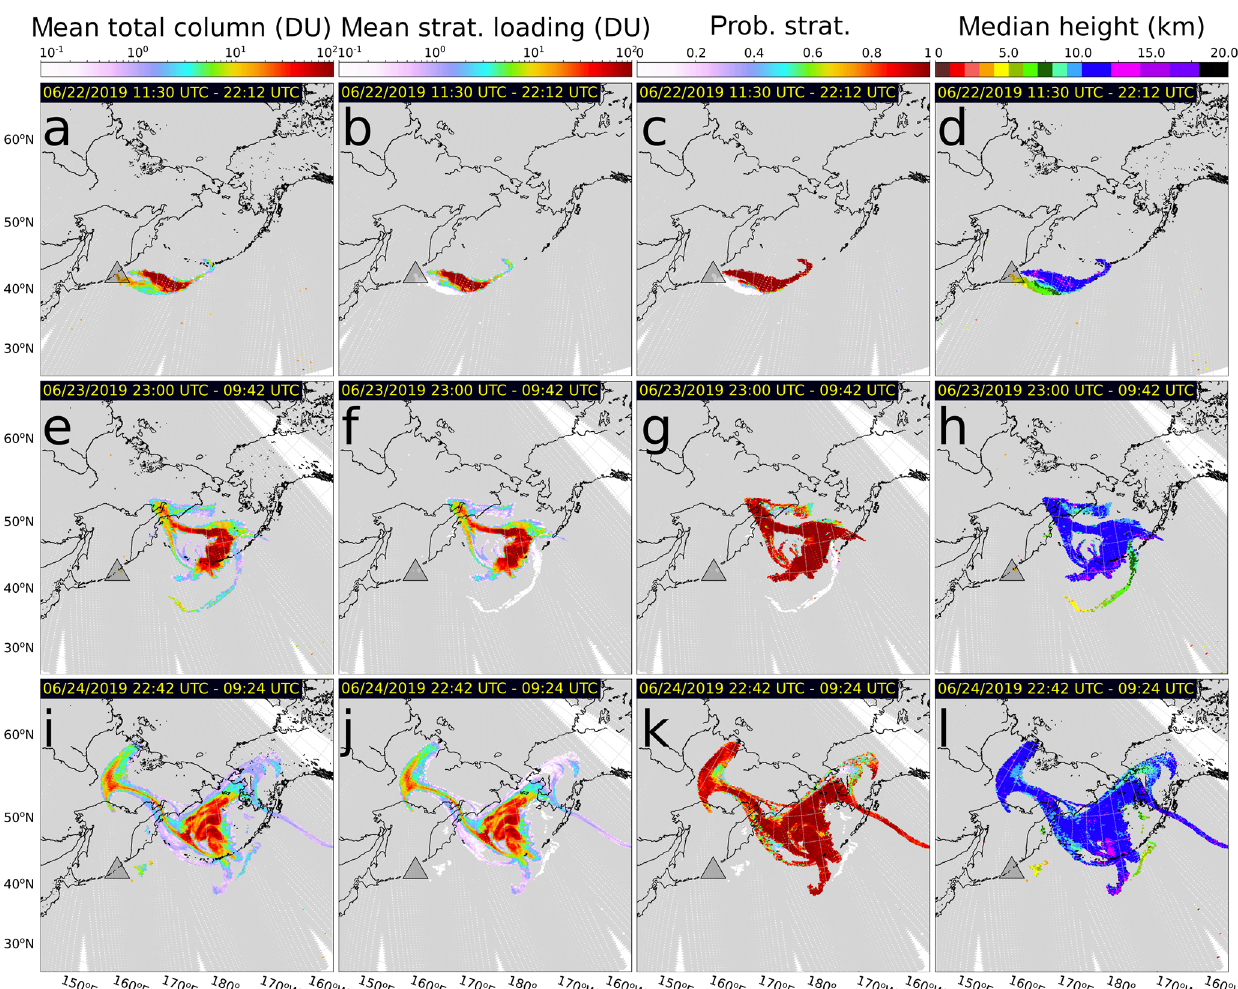
Figure 6. Time evolution (top to bottom) of the Raikoke SO 2 plume from NOAA-20 CrIS showing the expected-value total VCD (a, e, i) , the expected-value stratospheric partial VCD (b, f, j) , the probability that the SO 2 layer is in the stratosphere (c, g, k) , and the median layer height (d, h, l) . The height of the tropopause was calculated from daily NCEP reanalysis